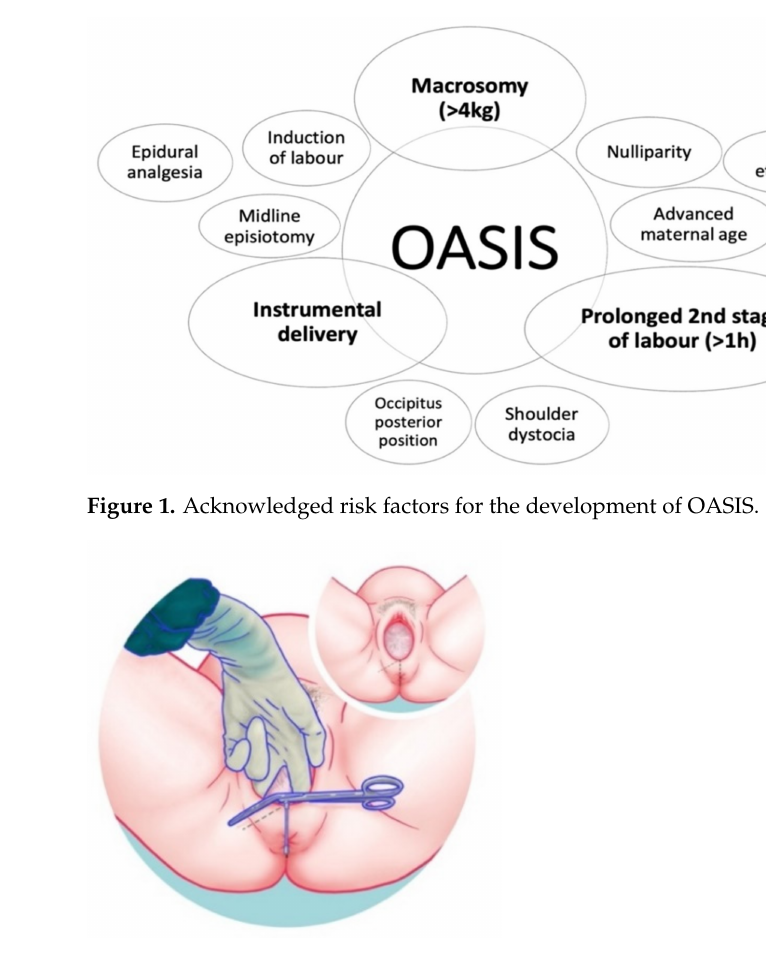
Figure 2. Mediolateral episiotomy with an angle of 45–60 degrees from the